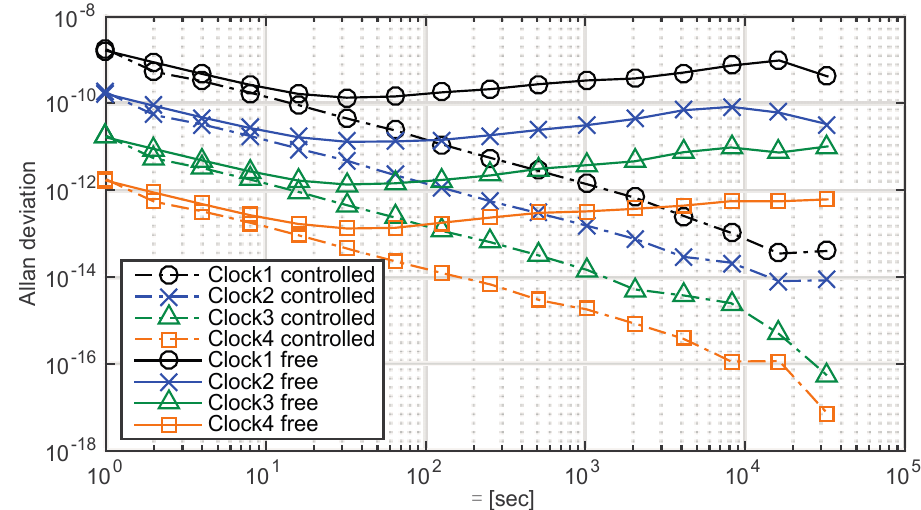
Figure 13. Comparison of the Allan deviations of four free run slave clocks and related controlled clocks. Data from the 1st h to the 24th h are truncated to evaluate the synchronization performance. The standard deviations of the stable loops and the free run clocks are 0.004 nanosecond, 0.04 nanosecond, 0.4 nanosecond,